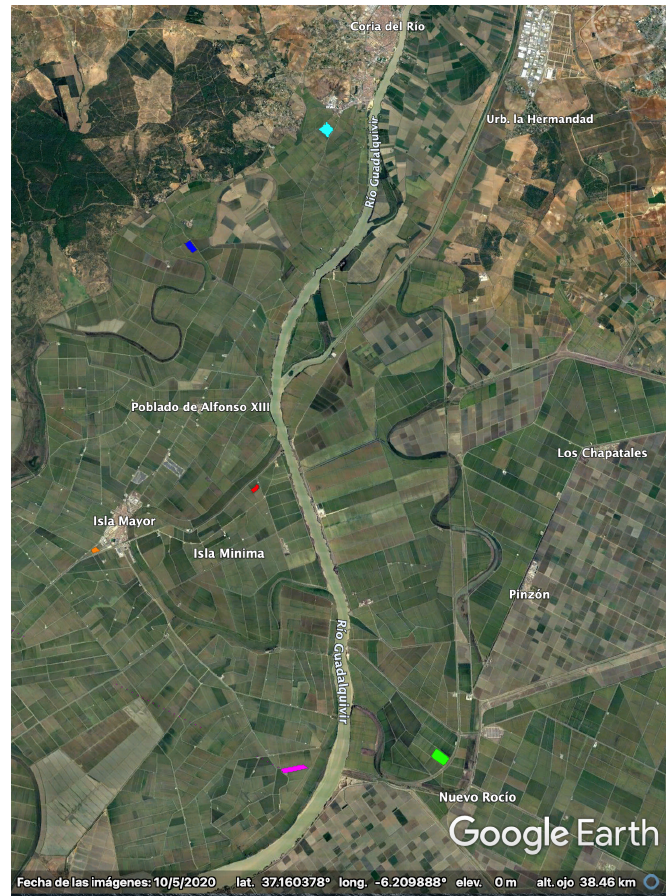
Figure 1. Google–Earth picture of the rice test site in Sevilla (37.1N, 6.15W). The polygons of the monitored parcels are overlaid with different